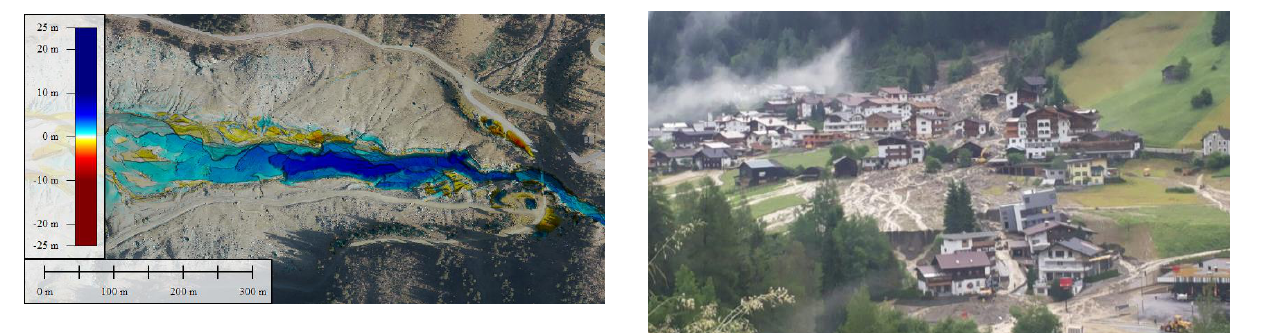
Figure 5. Terrain changes between 2010 and 2015 in the upper zone of the lake.